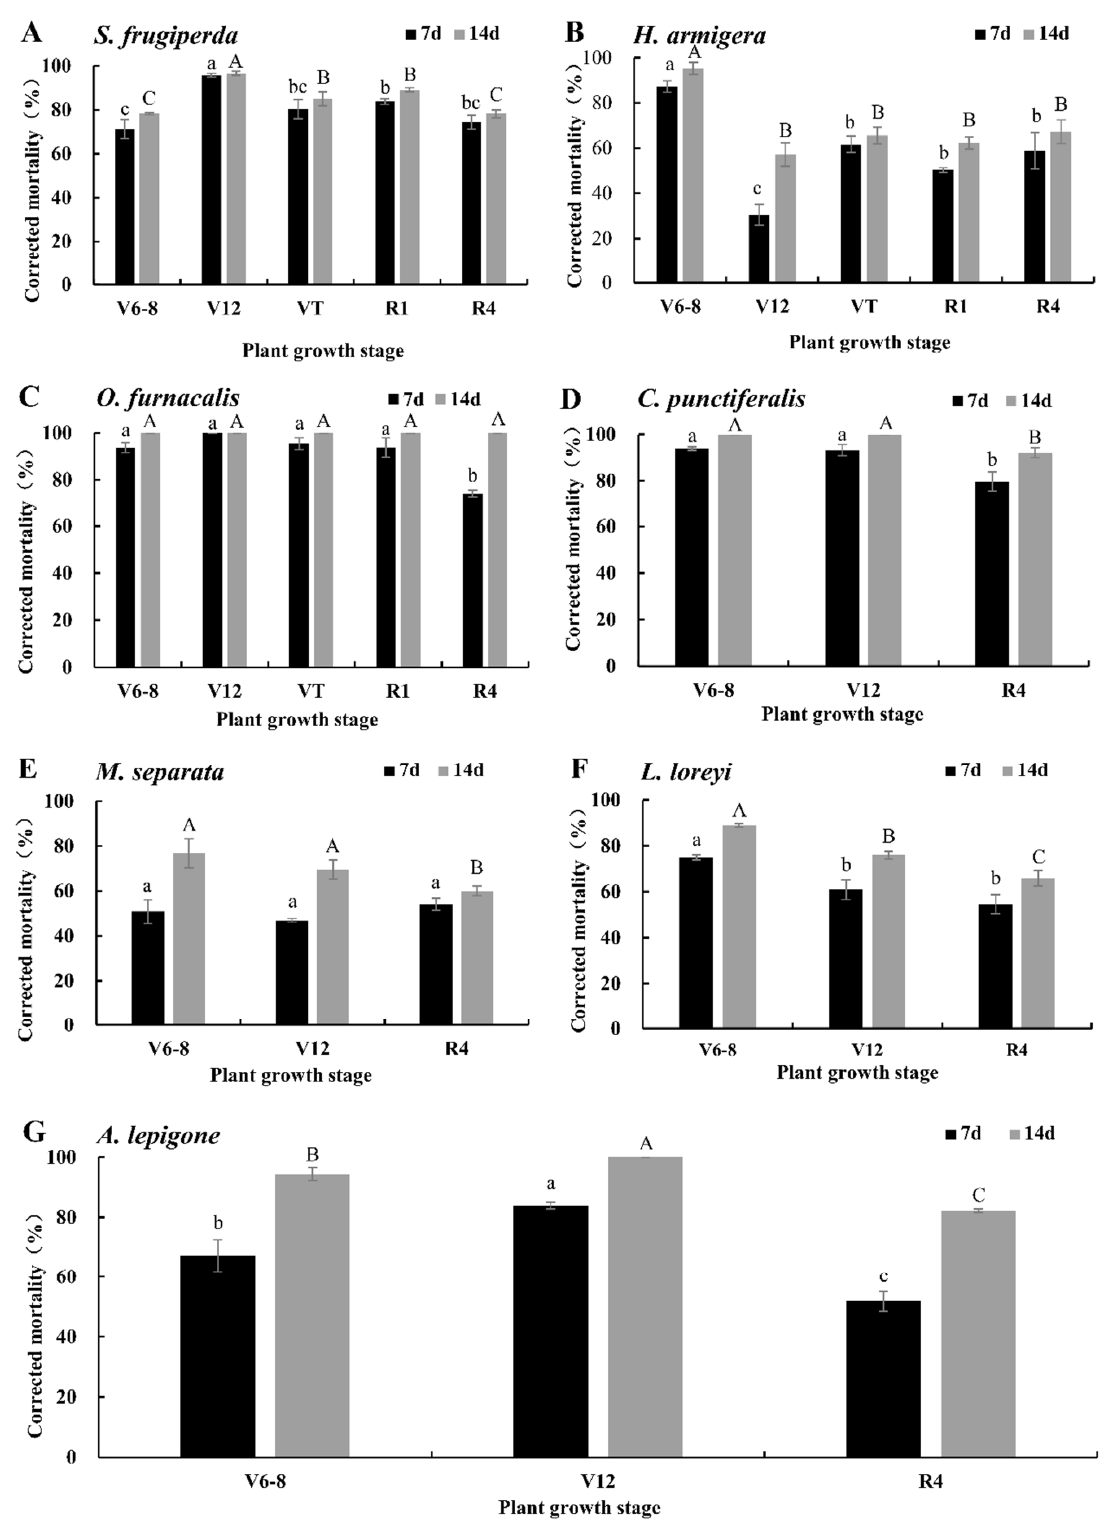
Figure 3. Corrected mortalities of neonates for seven lepidopteran pests on artificial diet containing lyophilized different tissues of Ruifeng 125 corn (expressing Cry1Ab/Cry2Aj) in different growth stages at a 25-fold dilution relative to the isogenic negative control. Values represent means ± SE. Different lowercase and uppercase letters above black and gray bars indicate significant difference for the same treatment time by Duncan’s multiple range test ( p < 0.05). ( A ) S. frugiperda ; ( B ) H. armigera ; ( C ) O. furnacalis ; ( D ) C. punctiferalis ; ( E ) M. separata ; ( F ) L. loreyi ; and ( G ) A. lepigone